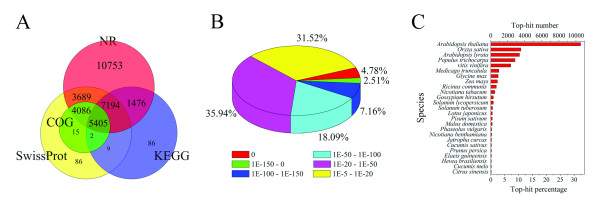
Characteristics of homology search of Chinese bayberry UniGenes. (A) Venn diagram of number of UniGenes annotated by BLASTx with an E-value threshold of 10-5 against protein databases. The numbers in the circles indicate the number of UniGenes annotated by single or multiple databases, (B) E-value distribution of the top BLASTx hits against the nr database for each UniGene, (C) Number and percentage of UniGenes matching the 25 top species using BLASTx in the nr database.